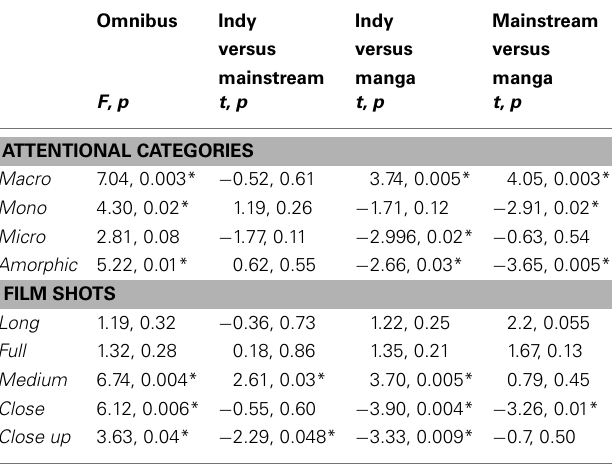
Table 1 | Comparisons of attentional categories and shots between